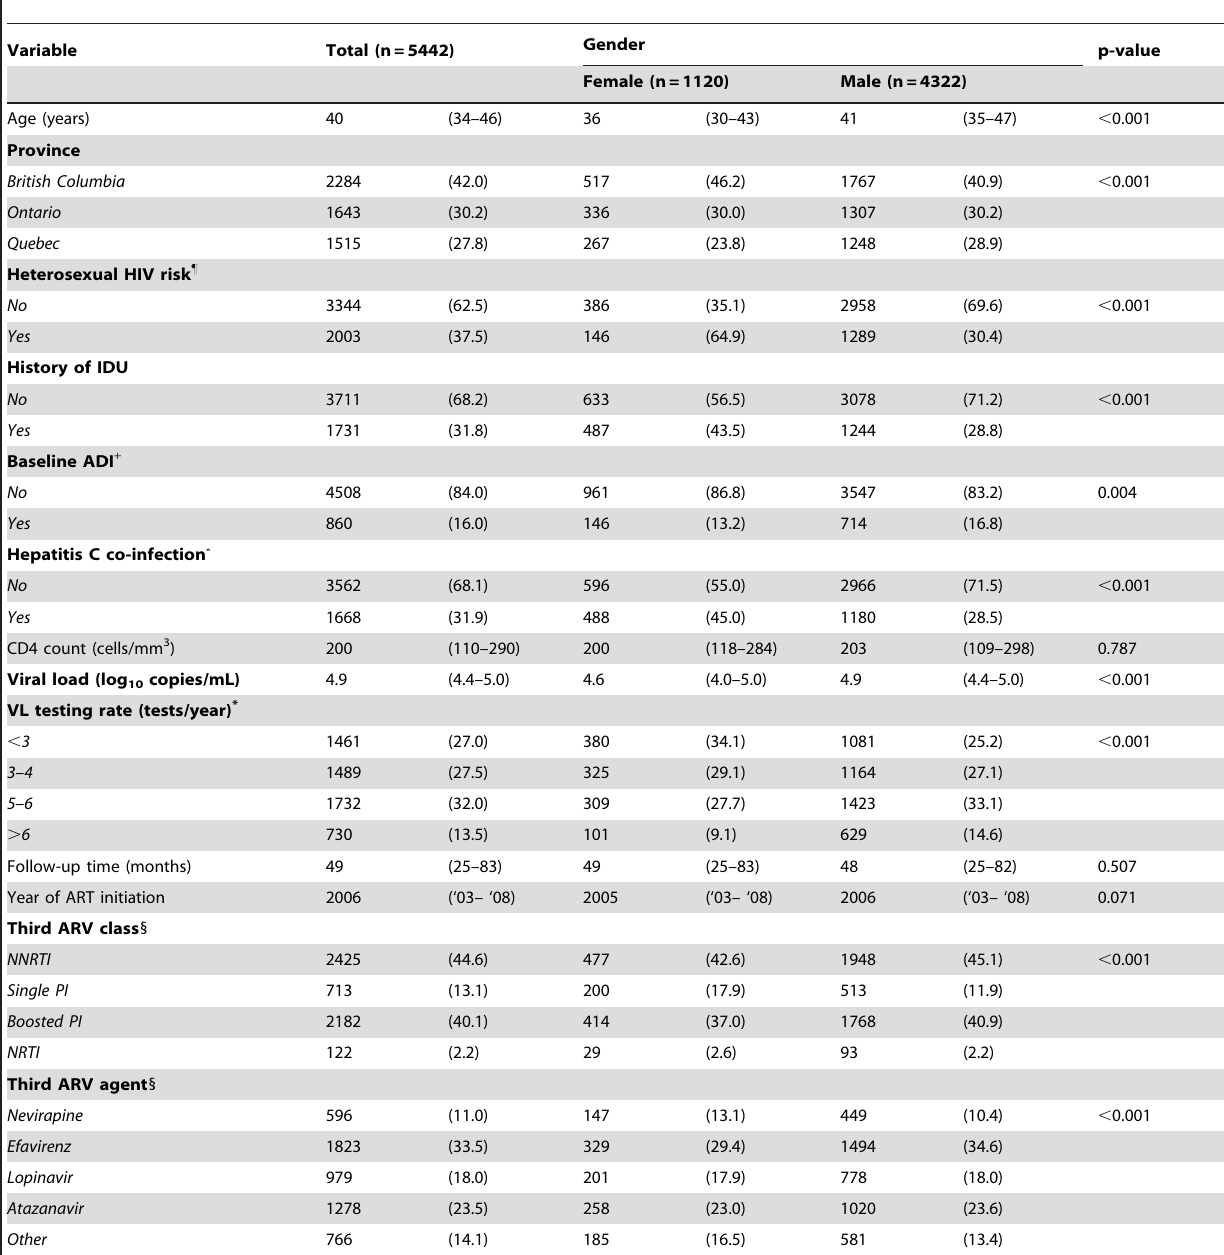
Table 1. Baseline demographic and clinical characteristics by gender